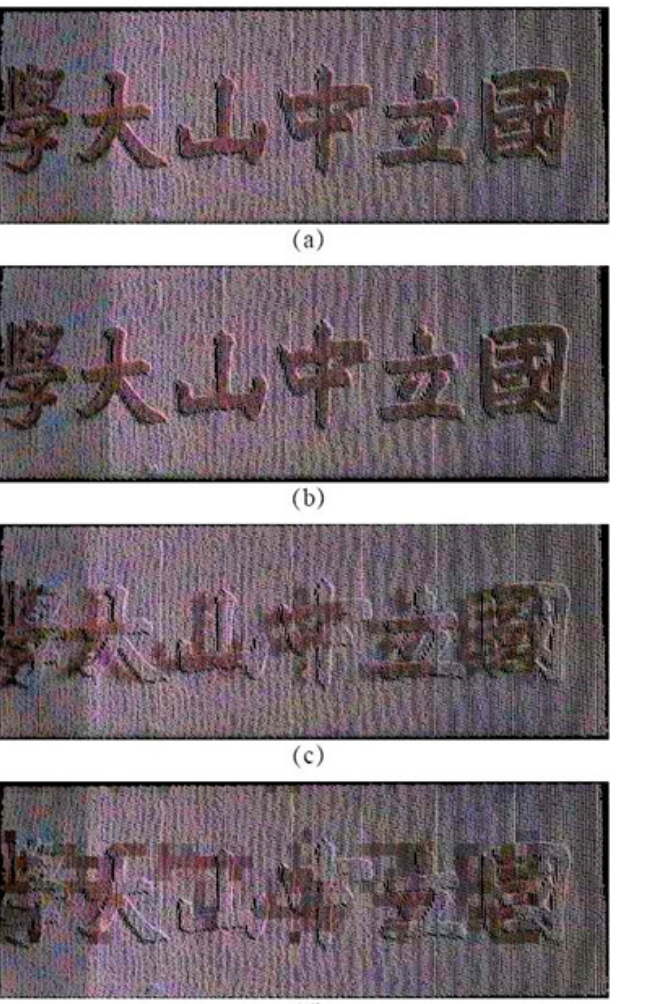
board with some Chinese characters (meaning: Sun Yat-sen University): ( a ) the original point cloud (object); ( b ) colorized